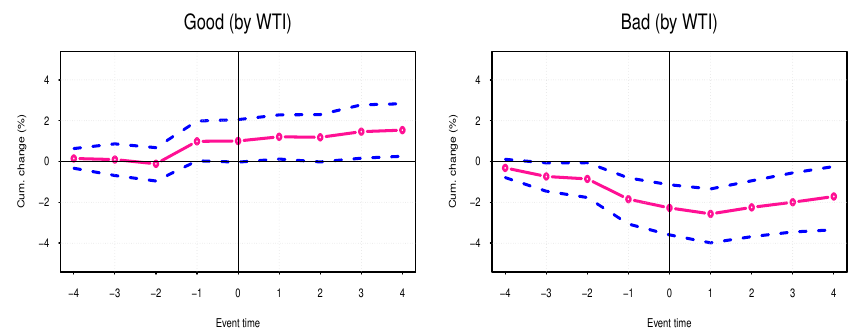
Figure 3. Extreme event on WTI oil and response of Wind.